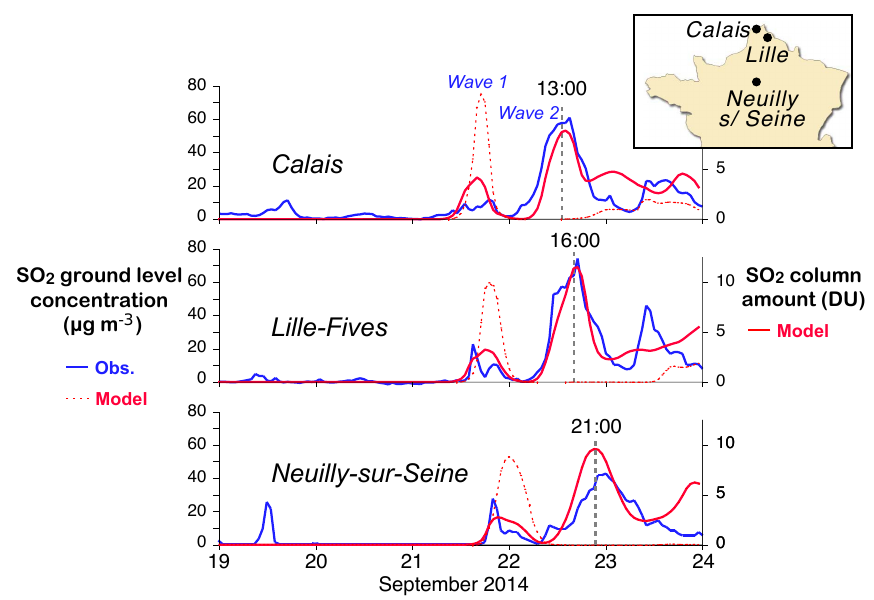
Figure 8. SO 2 ground-level concentration observed by air quality networks in France (blue) and modelled (dotted red), compared with modelled SO 2 vertical column amount (solid red).